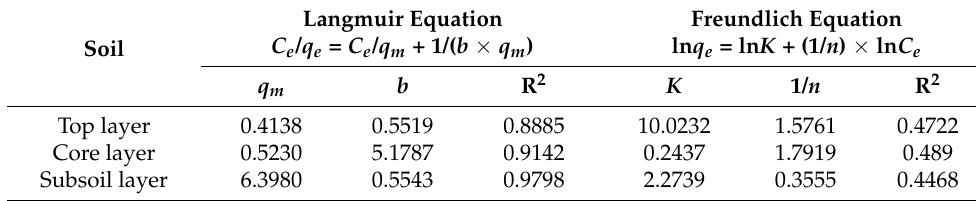
Table 3. Adsorption Isothermal Parameters.